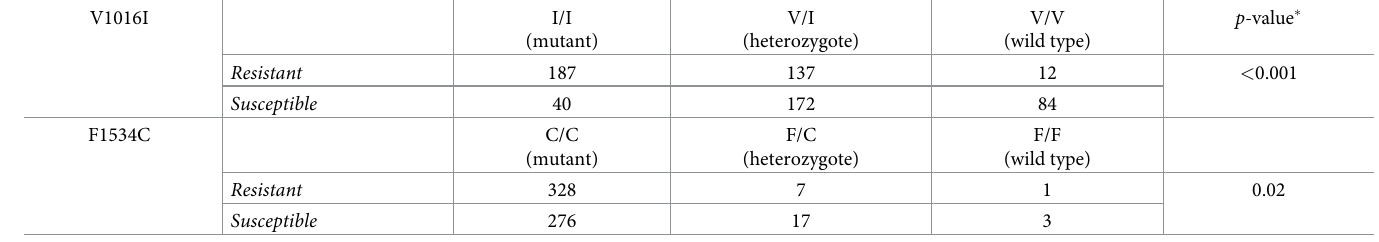
Table 1. Occurrences of V1016I and F1534C genotypes compared to pyrethroid-resistant phenotype. Fisher’s tests indicated significant associations between geno- types and phenotypes for resistance. V1016I